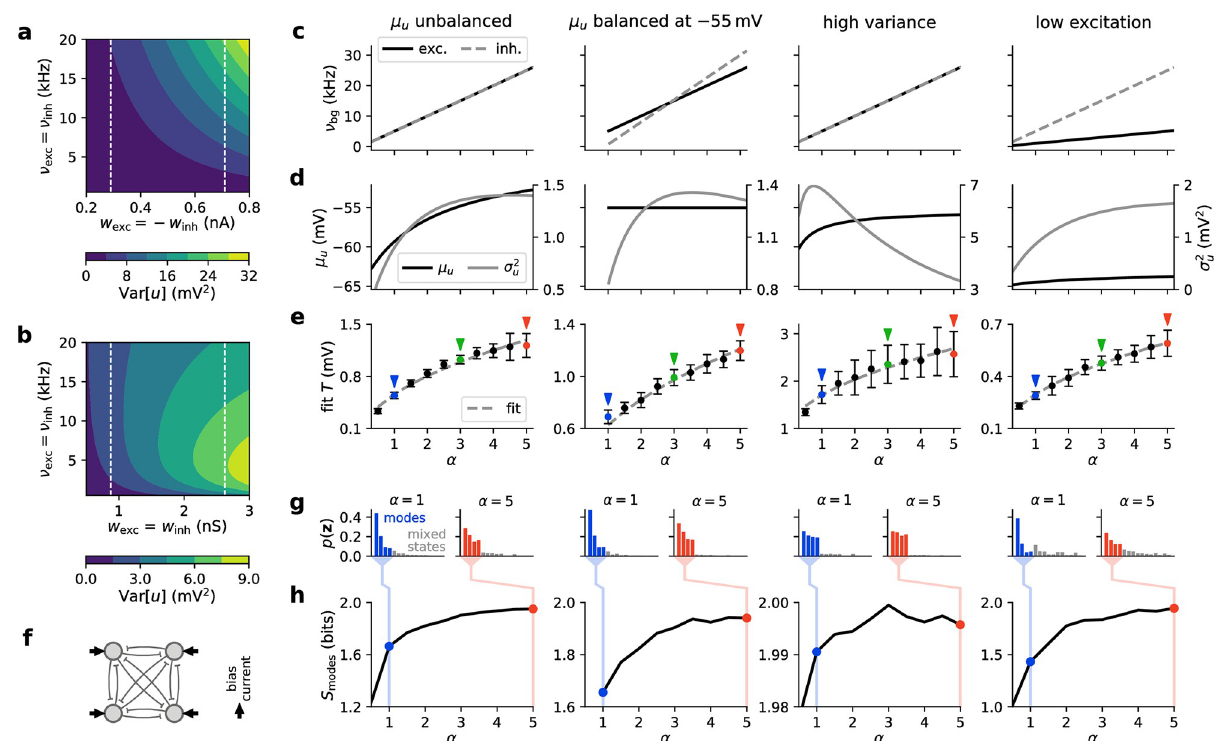
Fig 5. Background input rate sets the sampling temperature for conductance-based LIF neurons. (a, b) Variance of the free membrane potential for (a) current-based and (b) conductance-based synaptic interactions as a function of background rate and strength under balanced input rates and weights. Note that Var[ u ] is always monotonic in ν exc for current-based synapses, which does not hold for the conductance-based case (see the change of Var[ u ] along the dashed white lines). (c–e) The following panels show four different biologically interesting scenarios of conductance-based background input (ordered in columns). In each scenario, excitatory and inhibitory input is varied in different ways depending on a scaling parameter α (see Eq 11). Furthermore, the synaptic weights for background input are different in each scenario (see Section Conductance-based input scenarios in Methods). From left to right: μ u unbalanced (one of many possible settings in which μ u increases), μ u balanced at − 55 mV (with constant mean membrane potential close to the firing threshold), high variance (same as the first scenario but with larger synaptic conductances, resulting in a higher variance of the membrane potential), and low excitation (with a lower increase in excitation compared to inhibition). (c) Excitatory and inhibitory background input rates as a function of the scaling value α . Note that for the μ u balanced at − 55 mV scenario the balance can only be achieved for α � 1. (d) Mean and variance of free membrane potential resulting from background input scaled by α . (e) Temperature values resulting from fitting. Dots denote mean, whiskers standard deviation over N = 50 independent runs (see Section Fitting of stochastic models in Methods for details). Importantly, the temperature increases monotonically with α in all cases. The dashed gray line shows fits according to the theoretical prediction (Eq 4), closely matching mean values. The highlighted values correspond to low (blue, α = 1), medium ( α = 3) and high (red, α = 5) background input rates. See Section Fitting of stochastic models in Methods for a visualization of the resulting stochastic models and the soft threshold values u T . (f) Schematic drawing of the simple network used to illustrate the effect of changing background input rates on the distribution of network states. The network consists of four neurons connected with lateral inhibition, resulting in a network state distribution with four distinct modes (one neuron is active while the others remain silent). Each neuron receives a bias current input (arrows), the amplitude of which defines the probability of the mode corresponding to this neuron being active. See Section Illustrative sampling task for conductance-based networks in Methods for details. (g) Network state probabilities for low ( α = 1) and high ( α = 5) temperatures in a network simulation. Modes are shown in color; mixed states are shown in gray. At high temperatures, the distribution generally becomes flatter. (h) Entropy of modes at each value of α (in bits, calculated using Eq 35). The entropy increases as the mode distribution becomes flatter (i.e., closer to a uniform distribution). Note that while the temperature increases in all scenarios (see (e)), the values and changes of the entropy can vary